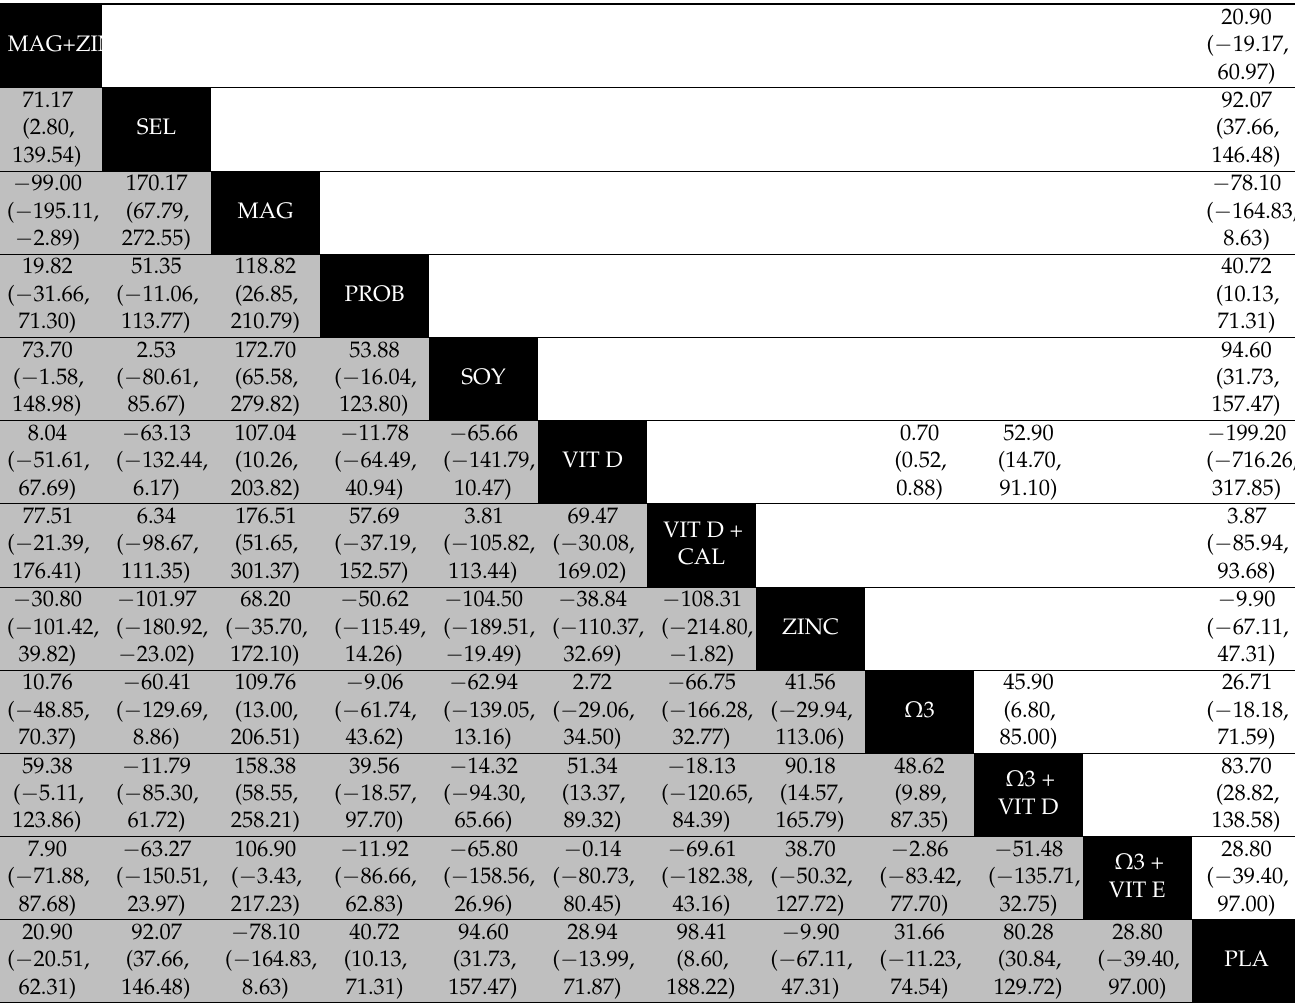
Table 7. Direct and indirect (in grey) estimates of the mean difference of ∆ GSH. Each column presents a different